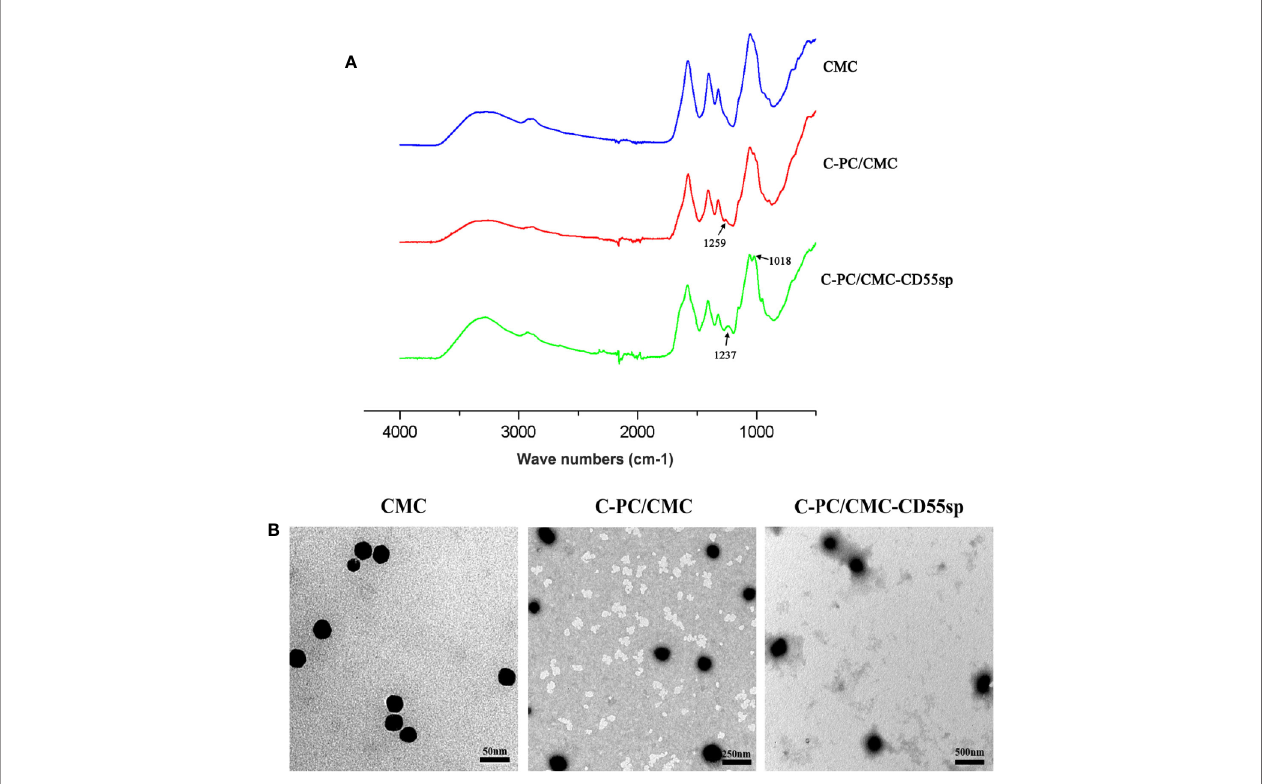
FIGURE 2 | Characterization of nanospheres. (A) FTIR spectra for Carboxymethyl Chitosan (CMC), C-Phycocyanin (C-PC)/CMC, and C-PC/CMC-CD55sp. (B) Morphology was determined using transmission electron microscopy. CMC, scale bars, 50 nm; C-PC/CMC, scale bars, 250 nm; C-PC/CMC-CD55sp, scale bars, 500 nm.